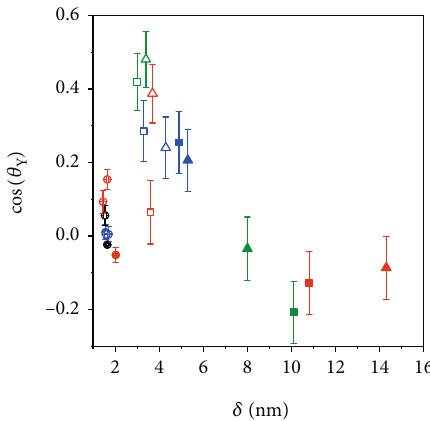
x Figure 5: Atom number fractions of oxygen x Þ as function of O , polar carbon C p , Y and nonpolar carbon x C np in the adsorbate layer. Results for di ff erent substrates: gold (circles), steel (triangles), and titanium (squares). Pretreatment: no-oil (open symbols) and with oil ( fi lled symbols). Cleaning: CCC (blue), AAA (red), III (green), and NC (black). The results for gold were obtained in the present work; the other results are taken from Becker et al. [20]. No error bars are depicted for clarity. The one-parametric empirical correlation (Equation (8)) is shown as black line.